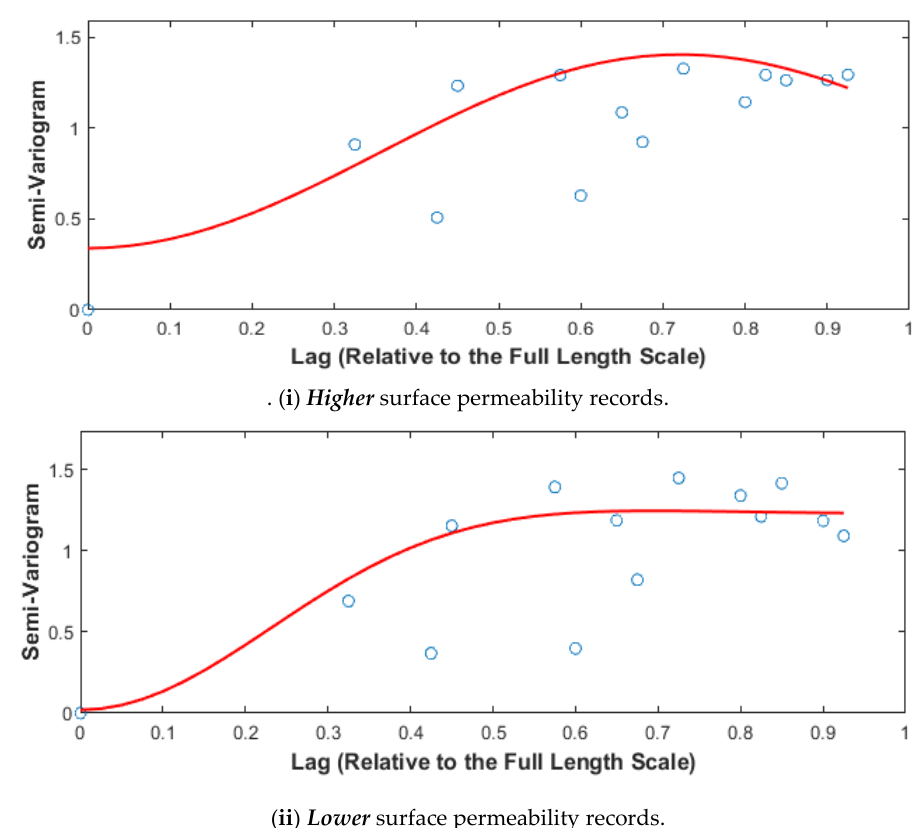
Figure 15. Semi-variograms for the kriging procedure for the Lac du Bonnet granite.